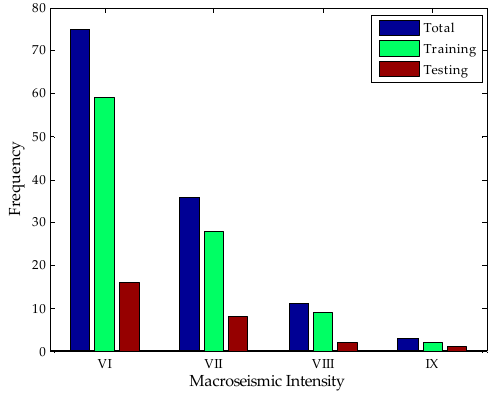
Figure 5. Histogram of the macroseismic intensity dataset.